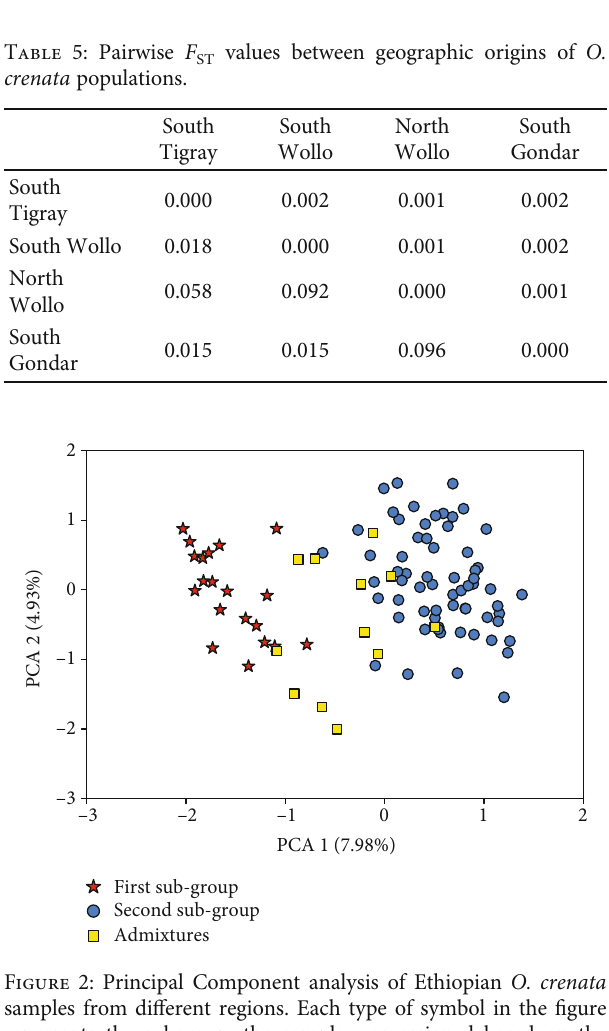
Figure 2: Principal Component analysis of Ethiopian O. crenata samples from di ff erent regions. Each type of symbol in the fi gure represents the subgroup; the sample was assigned based on the structure grouping